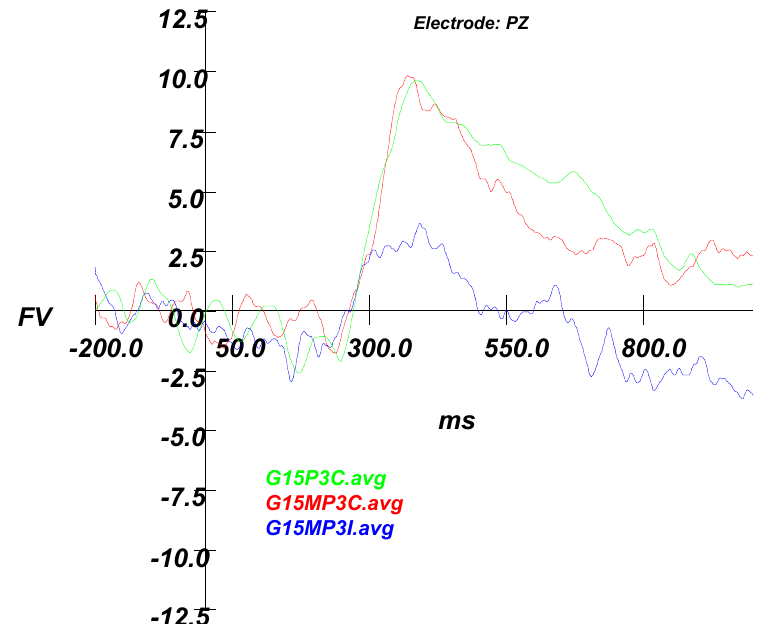
Figure 5. Experiment 2 grand average waveforms for Full Effort correct trials (Green) are not different from Malingering correct trials (Red), which are both different from Malingering incorrect trials (Blue). G15P3C = Grand Average Full Effort P3 Correct; G15MP3C = Grand Average Simulating P3; CorrectG15MP3I = Grand Average Simulating P3 Incorrect.